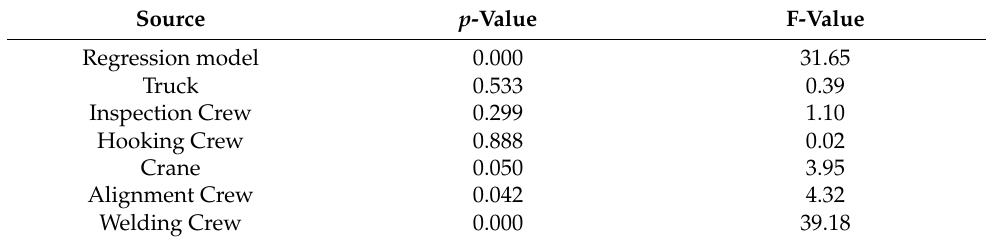
Table 7. Analysis of variance (ANOVA) testing for the